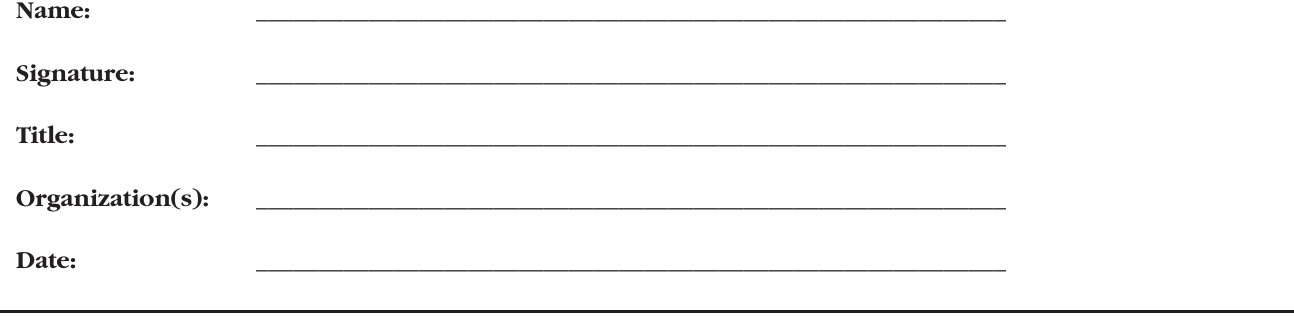
Figure 4. General Release